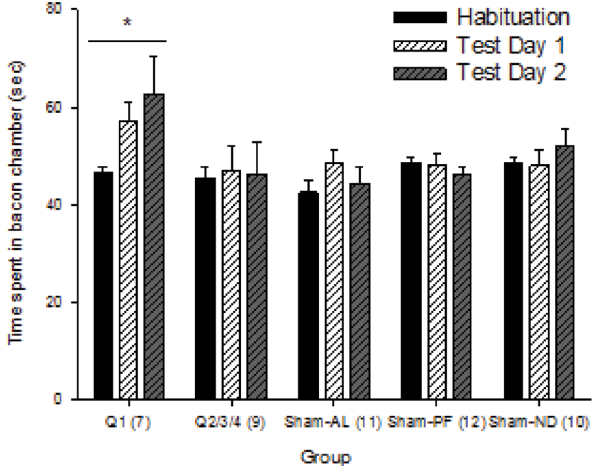
Fig 5. Healthy RYGB rats (Q1) showed significant bacon CPP. To quantify preference for the bacon- paired chamber, the amount of time each animal spent in the bacon-paired chamber was standardized to total time in both chambers. There was a bypass-specific increase in bacon-chamber preference after conditioning (Test Days 1 and 2) relative to Habituation Day, yet importantly, this behavioral response was strictly observed in the RYGB animals that responded well to the surgery ( * unadjusted p < 0.05 compared to Habituation